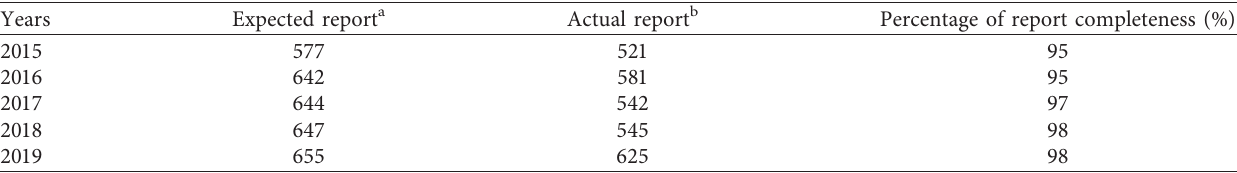
Table 2: Zonal surveillance report (from all health facilities) completeness by year in the Jimma Zone, Oromia Region, from 2015 to 2019.